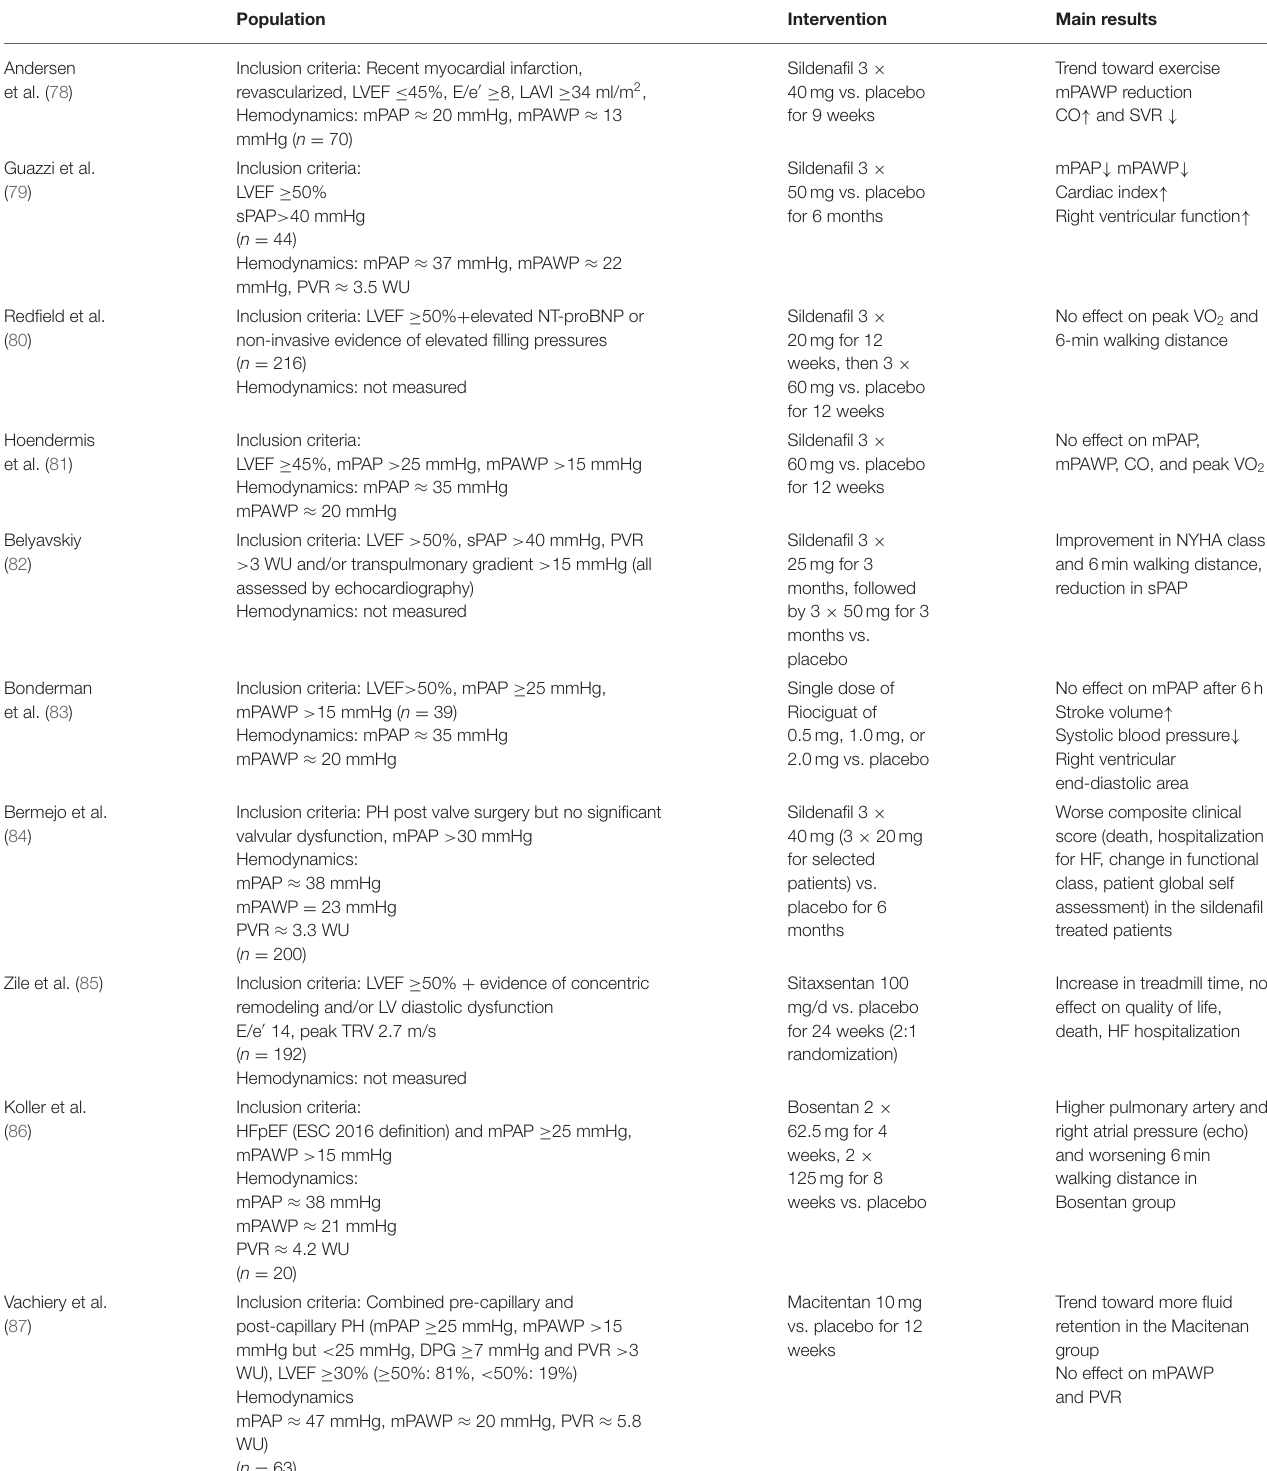
TABLE 5 | Studies on pulmonary arterial hypertension targeted therapeutics in patients with heart failure (HF) with preserved (HFpEF) or mid-range (HFmrEF) left ventricular ejection fraction (LVEF) with or at risk for pulmonary hypertension. Population Intervention Main